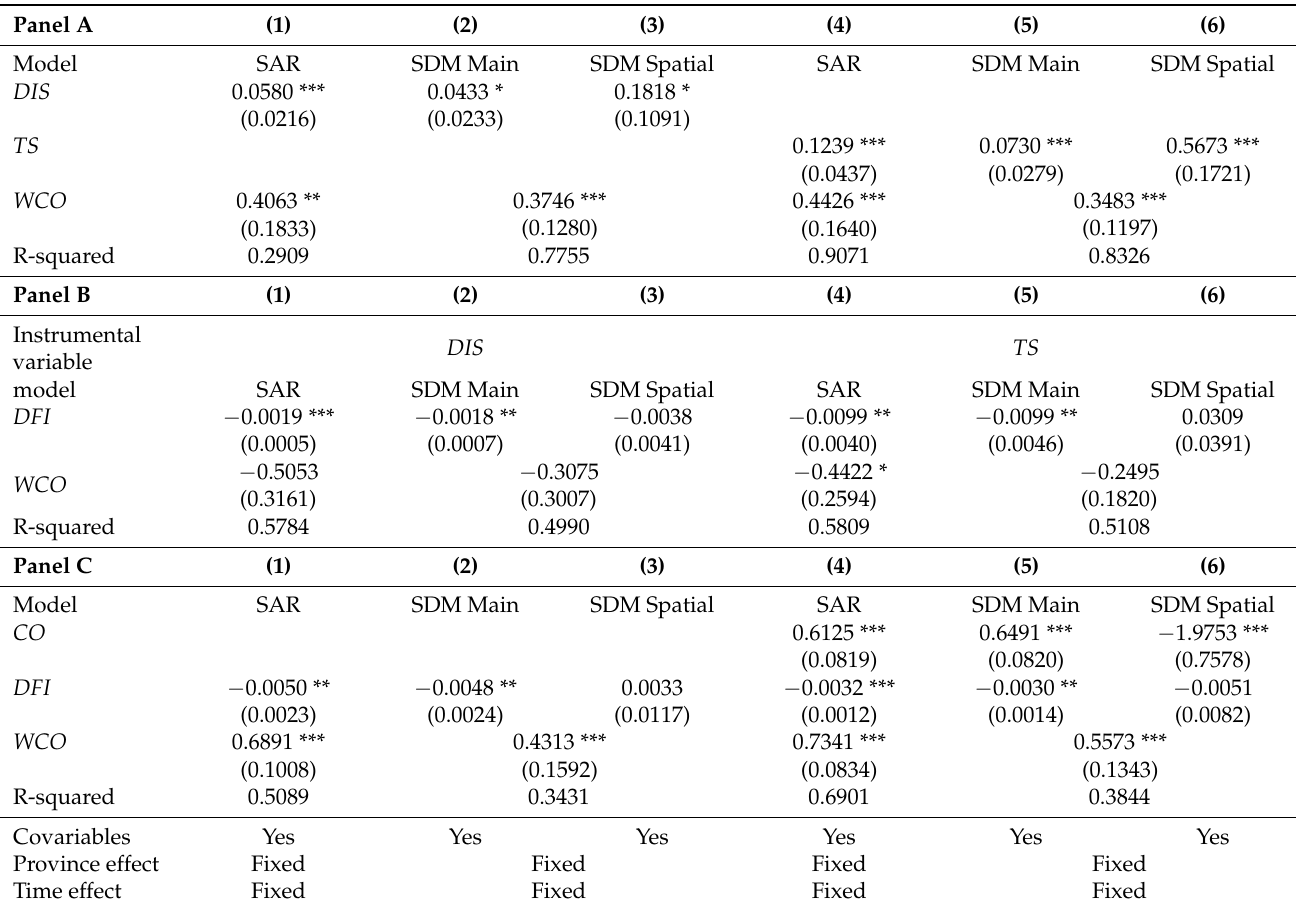
Table 4. Regression results of endogenous